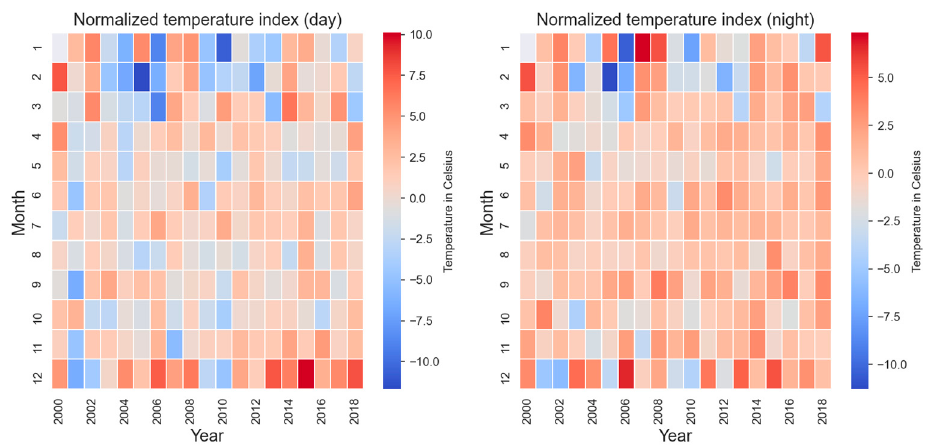
Figure 6. Normalized temperature index (day and night) from 2000–2018.